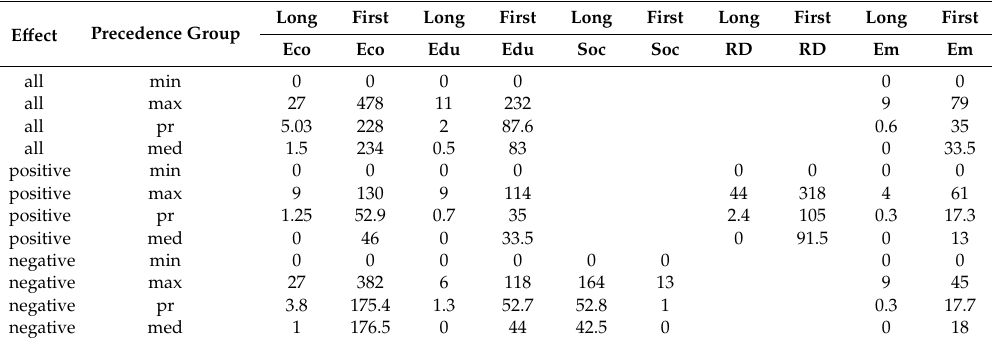
Table 7. First and long precedencies by years.